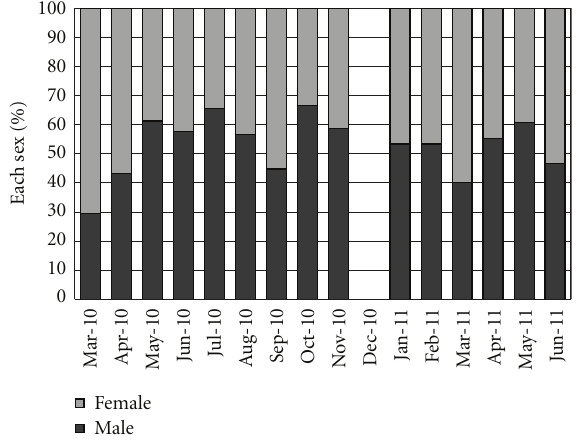
Figure 3: Sex ratio of Mya arenaria sampled at Bannow Bay over study